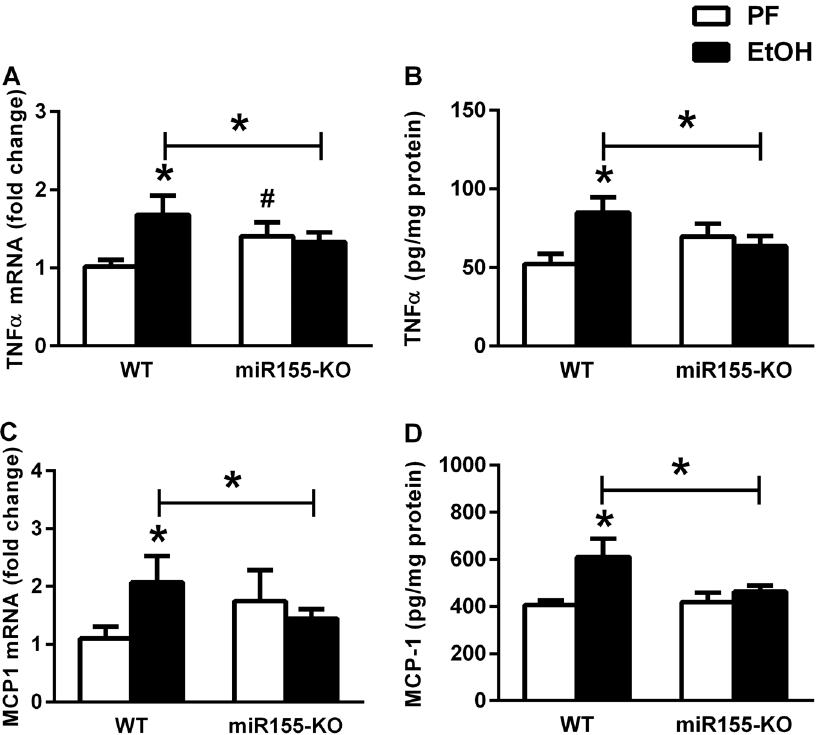
Figure 2. MicroRNA-155 deficiency protects from alcohol-induced TNF a and MCP1 in mouse cerebellum. WT (n=6 or 7) or miR-155-KO (n=5 or 10) mice were fed with control (PF) or EtOH diet for 5 weeks, respectively. Pro-inflammatory cytokines, TNF a (A) and MCP1 (C) mRNAs were assessed by real-time PCR from whole cerebellar RNA extract and corrected with 18S. TNF a (B) and MCP1 (D) proteins of whole cerebellar lysates were measured by specific ELISAs and corrected with total protein. Bars represent mean 6 SEM (*, # : p value , 0.05 relative to appropriate PF or WT controls, respectively, by Kruskal-Wallis non-parametric test).